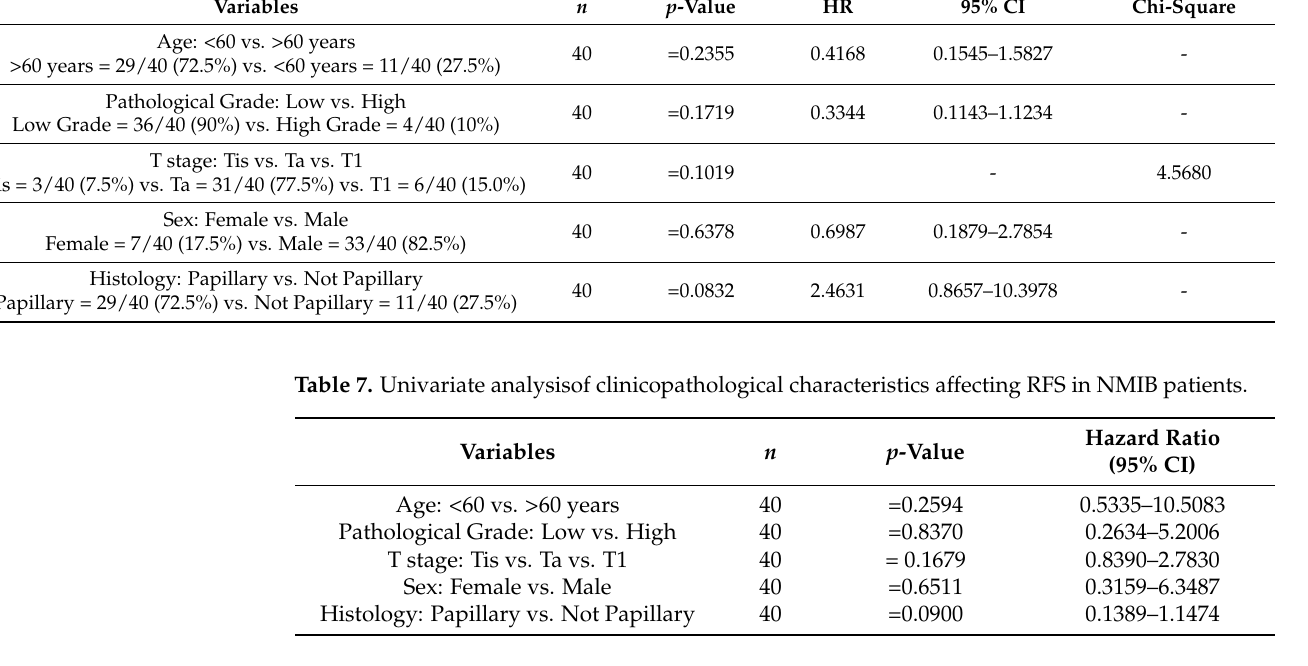
Table 6. Correlation analysis by Kaplan-Meier between patients’ characteristics and RFS.